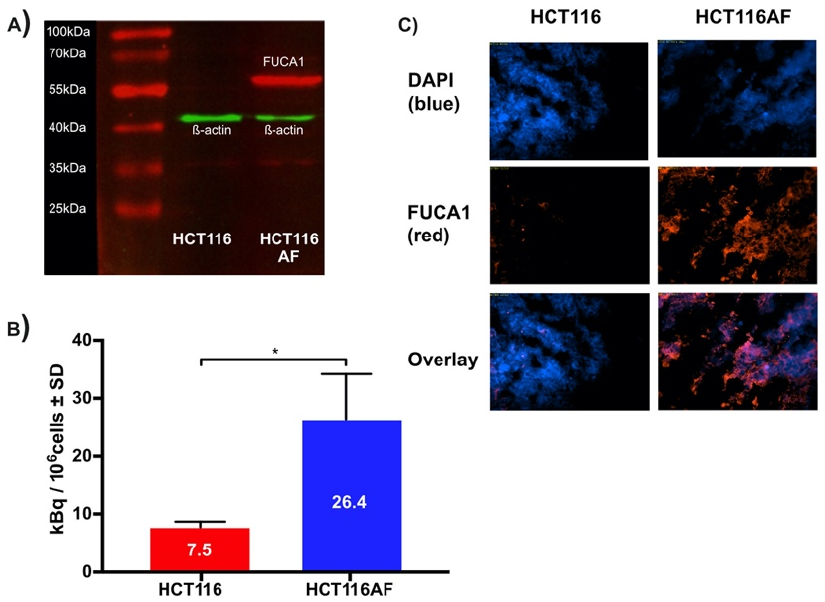
Figure 3. Validation of in vitro tracer uptake and expression of AF in HCT116AF and xenograft tissue: ( A ) Western blot showing expression of AF in transfected HCT116 cells. Protein bands were stained with primary anti-DDK2 and Alexa Fluor 555 labeled fluorescent secondary antibodies; ( B ) In vitro evaluation of tracer uptake revealed 3.5-fold higher tracer accumulation in HCT116AF vs. HCT116 cells, with respective uptake values of 26.4 ± 7.8 and 7.5 ± 1.0 kBq/10 6 cells ( p < 0.05); ( C ) Ex vivo analysis of HCT116AF tumors revealed positive staining for DDK2, indicating that the transfected cells express AF in vivo (* p < 0.5) .